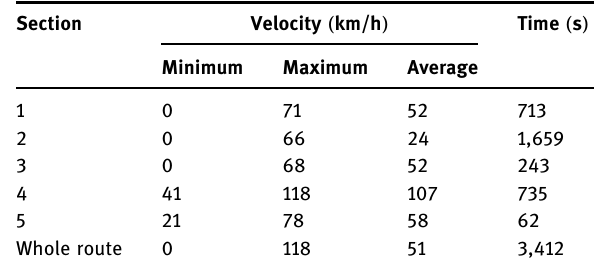
Table 2: Vehicle motion parameters – afternoon drive